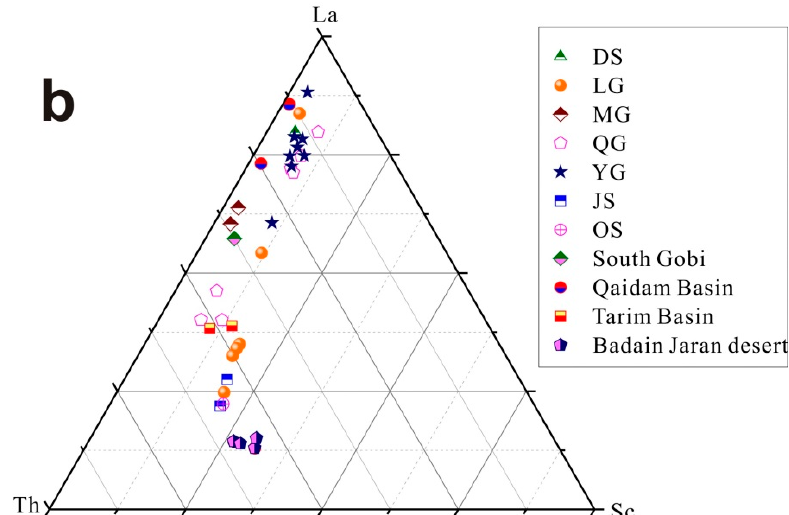
Figure 5. TiO 2 –Zr–Al 2 O 3 and La–Th–Sc diagrams ternary of cryoconite and snow dust collected in the various glaciers and snowpacks. Literature data of intrusive rocks from potential dust source areas in the Tarim Basin [36], the South Gobi [32], the Qaidam Basin [37] and the Badain Jaran desert [38] are also included for comparison. ( a ) TiO 2 –Zr–Al 2 O 3 of cryoconite and snow dust compositions; ( b ) La–Th–Sc of cryoconite and snow dust compositions by comparison with those of potential dust sources. Compared with the Qilian Mountain locations (e.g., QG, LG, DS, and OS), samples from